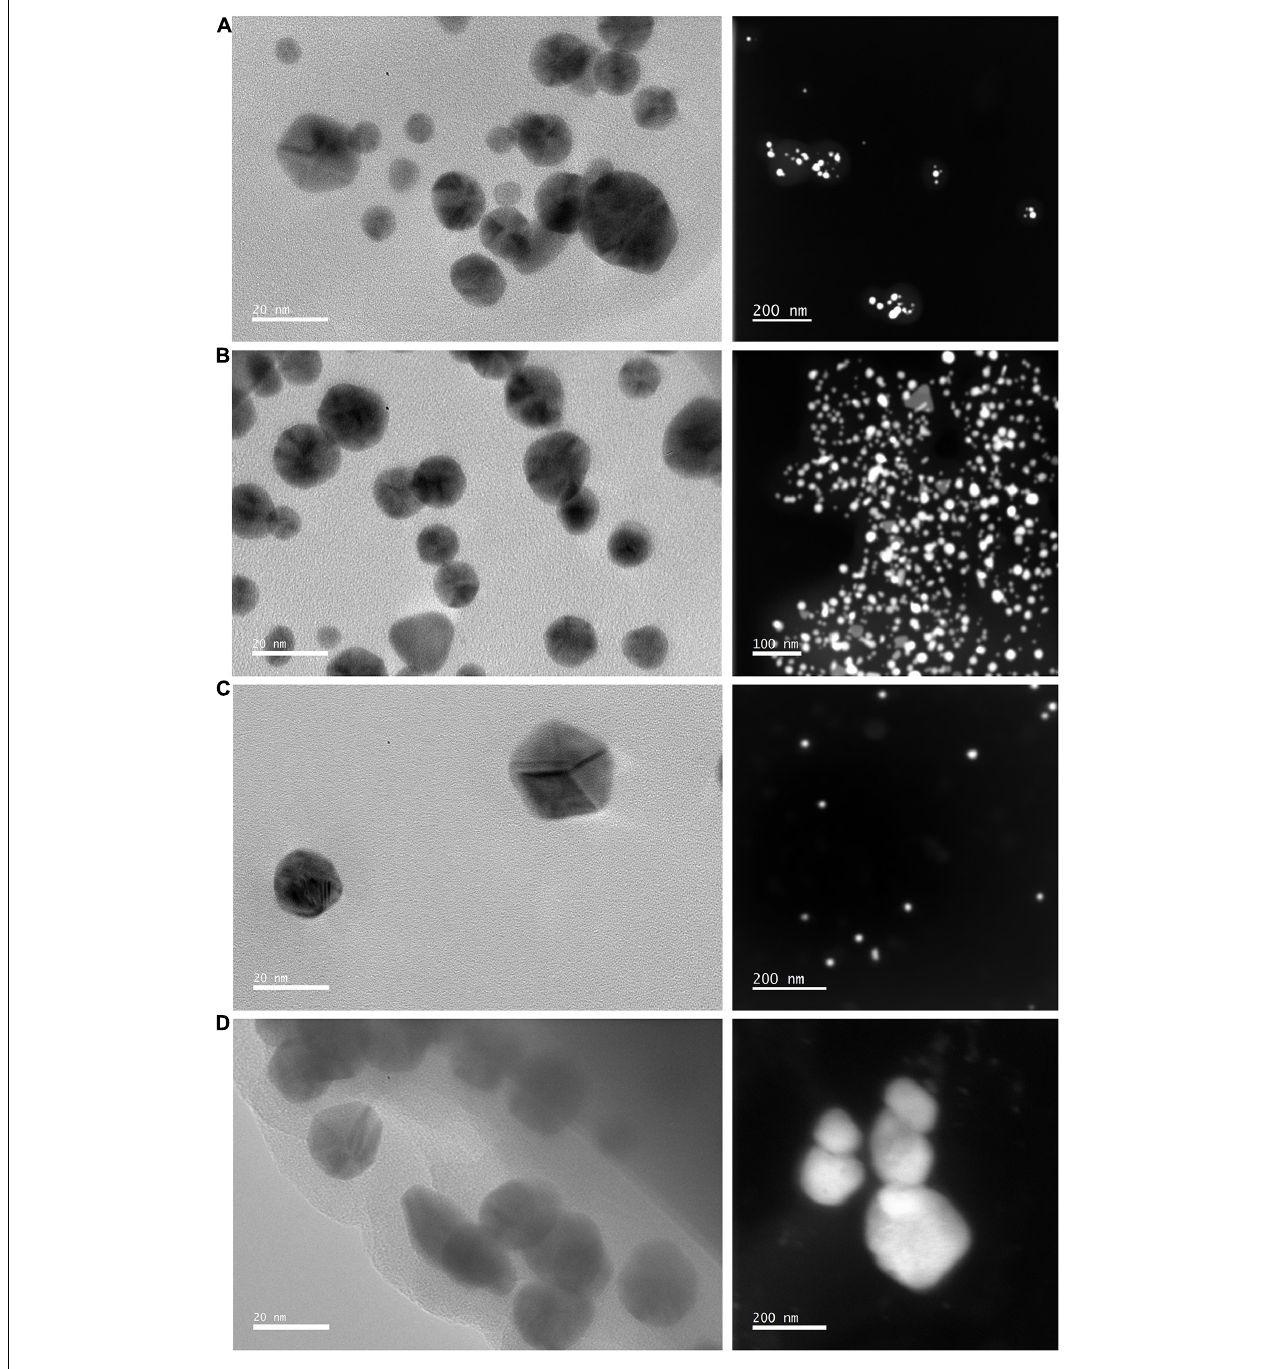
FIGURE 3 | High Resolution Transmission electron micrographs and Scanning Transmission Electron micrographs (STEM) of (A) Helichrysum odoratissimum methanol extract + Gum arabic, (B) H. odoratissimum – Gum arabic gold nanoparticles, (C) H. odoratissimum leaf powder + Gum arabic, and (D) H. odoratissimum leaf powder – Gum arabic gold